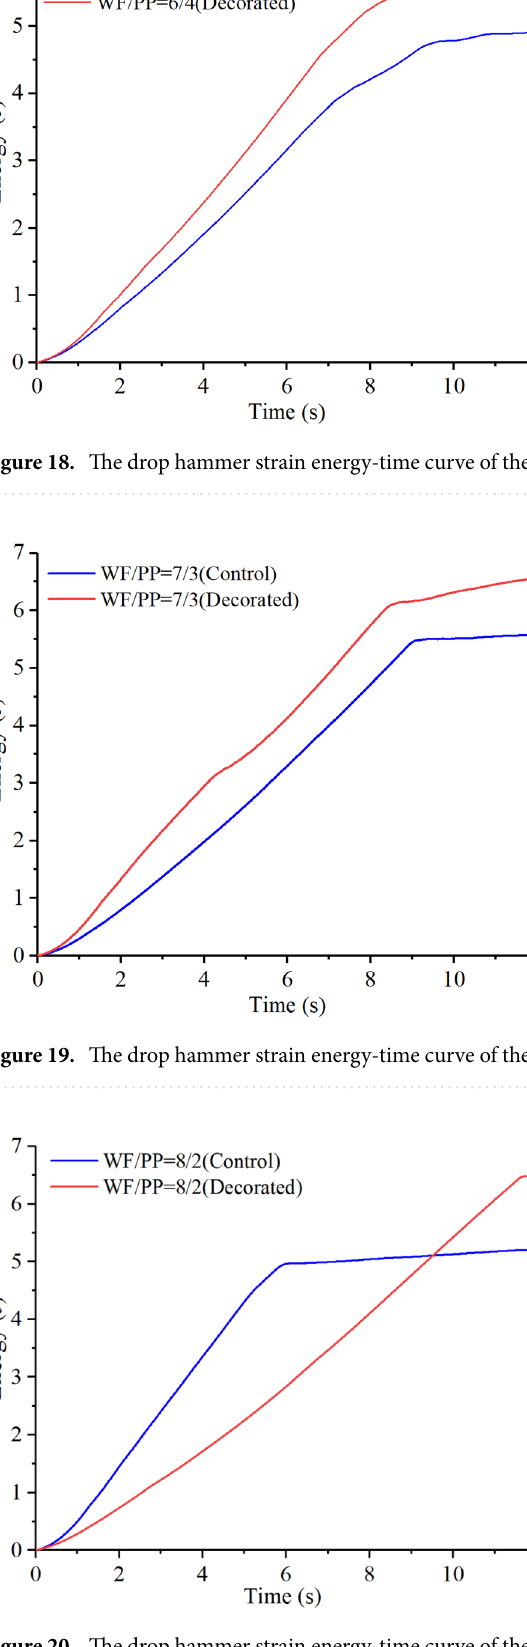
Figure 20. The drop hammer strain energy-time curve of the WF/PP = 8/2